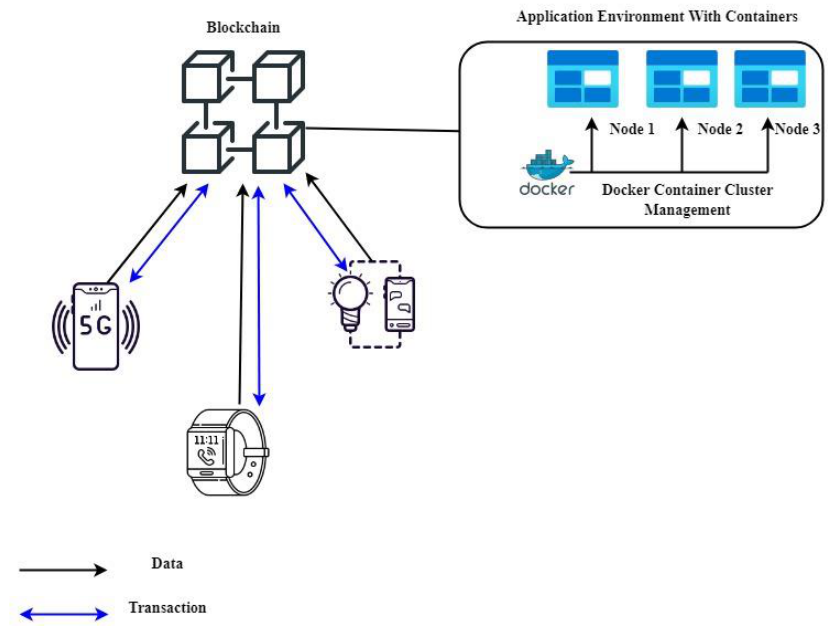
Figure 14. Deploy docker container integrate in